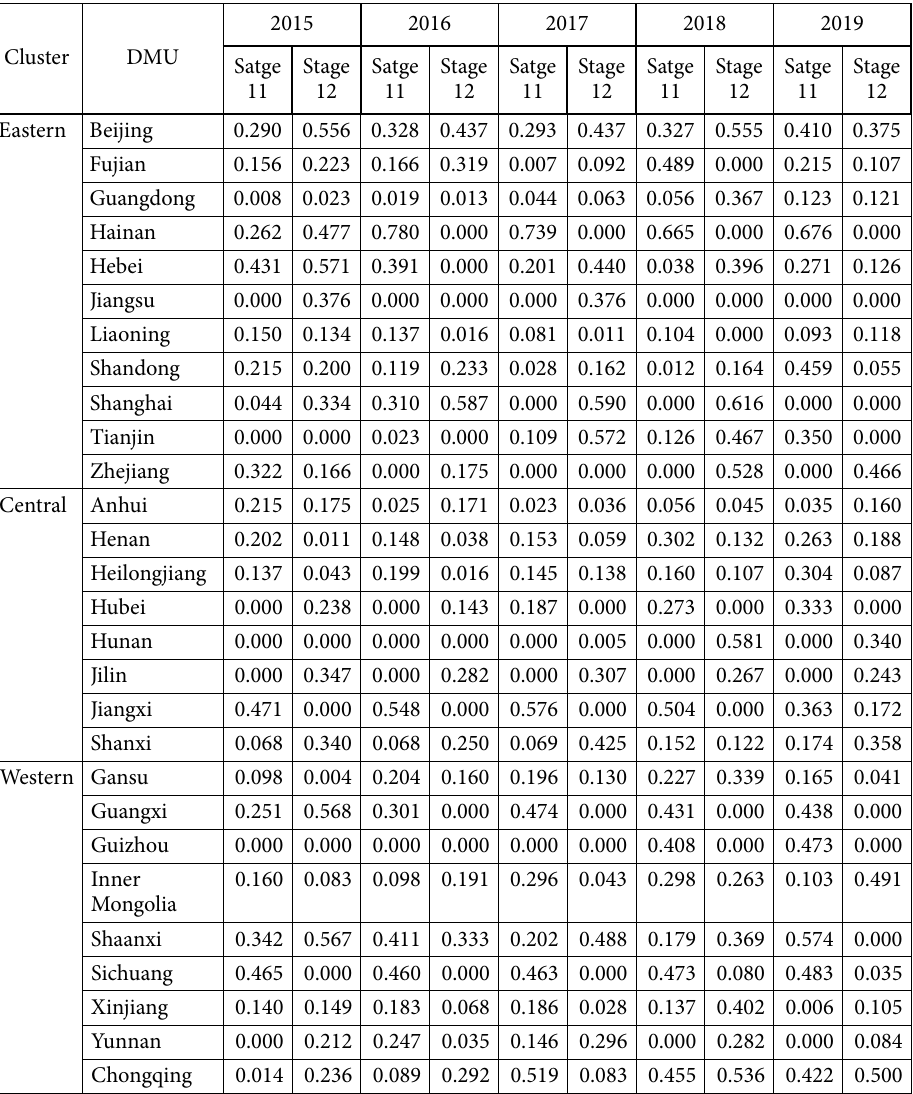
Table 6. Efficiency difference between university stage, enterprise stage, and economic and environment stage from 2015 to